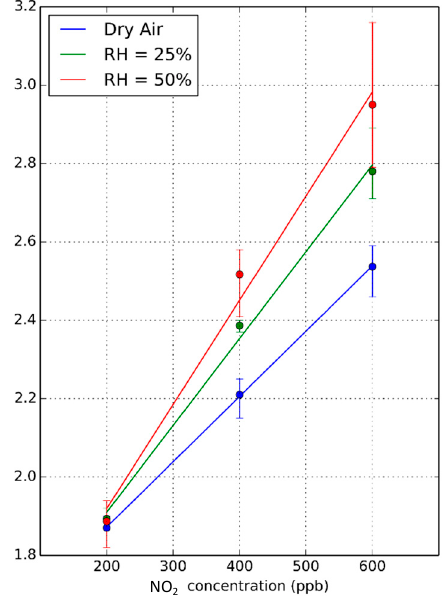
Figure 9. Calibration curves obtained from the rate of resistance change when pulsed UV light is OFF for three different humidity levels and for a sensor operated at 50 °C. Error bars correspond to the maximum and minimum values for the set of measurements gathered.